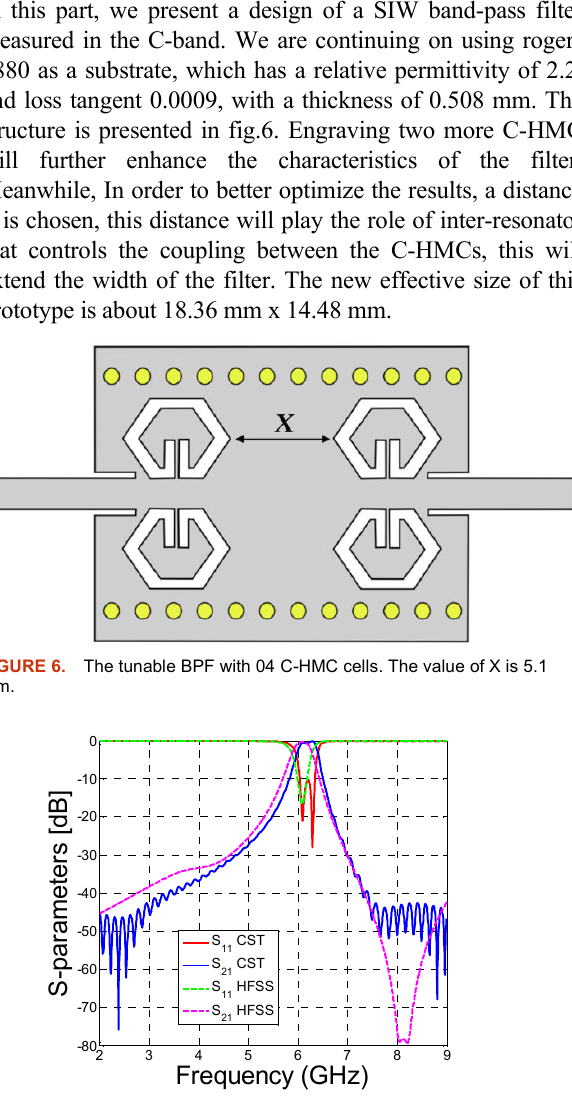
FIGURE 7. Simulation results of the Band-pass filter with 04 C-HMC.